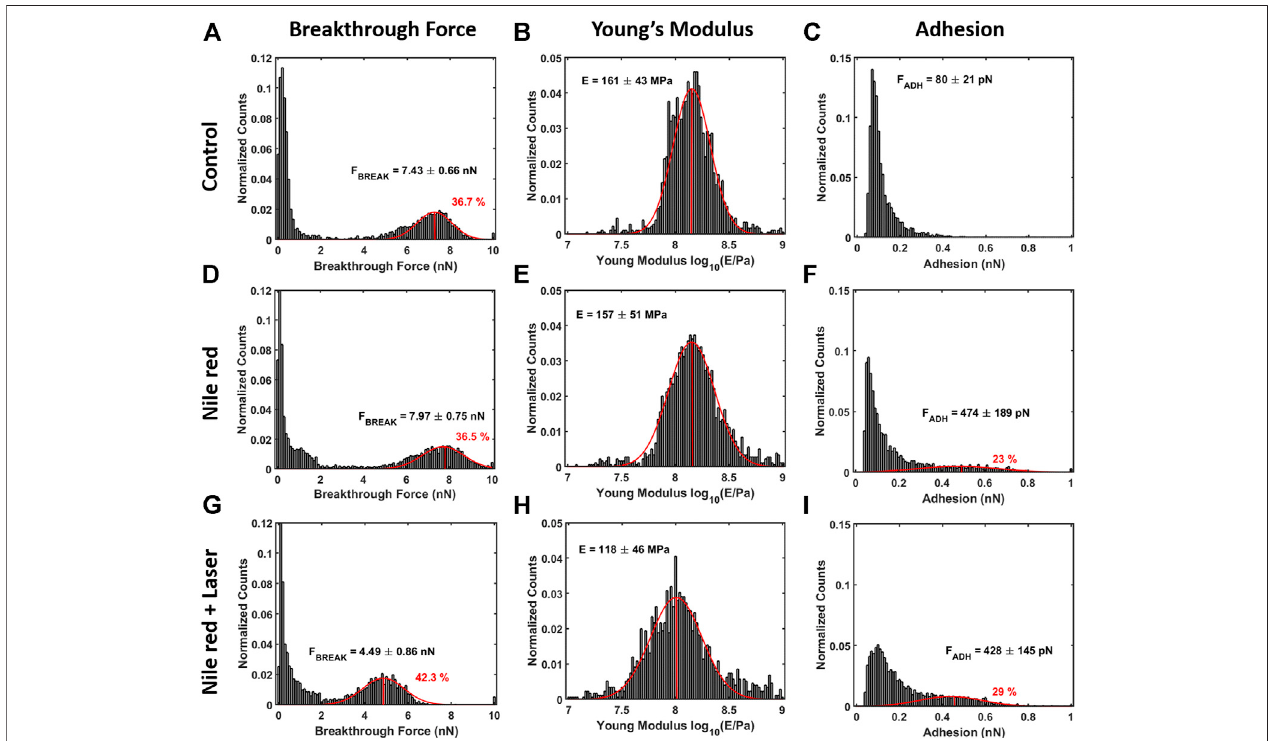
FIGURE 7 | Quanti fi cation with histograms and Gaussian fi t relative to mechanical analysis. (A) Breakthrough force histogram of fi rst layer, (B) Young ’ s Modulus histogram and (C) adhesion histogram on control DOPC bilayer. With the same order ofDOPC control (A – C) , DOPC after 30 min incubation with 2.5ug/ml Nile red with DMSO at 2.5% (D – F) ), and after irradiating probe region with 35.4 mW/ μ m 2 green laser (G – I) . Gaussian fi tting and average are depicted for fi rst and additional layers, while percentages are indicative of area coverage (events falling in under the fi t curve). The peaks around zero breakthrough force in (A,D,G) re fl ect the fact that some parts of the mica surface were not covered by DOPC bilayer. Counts of vertical axis are normalized on total number of traces